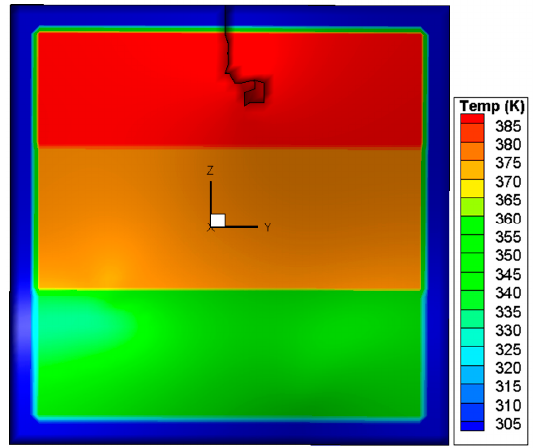
Figure 22. Crack path predicted by the CTOD-based crack growth criterion.